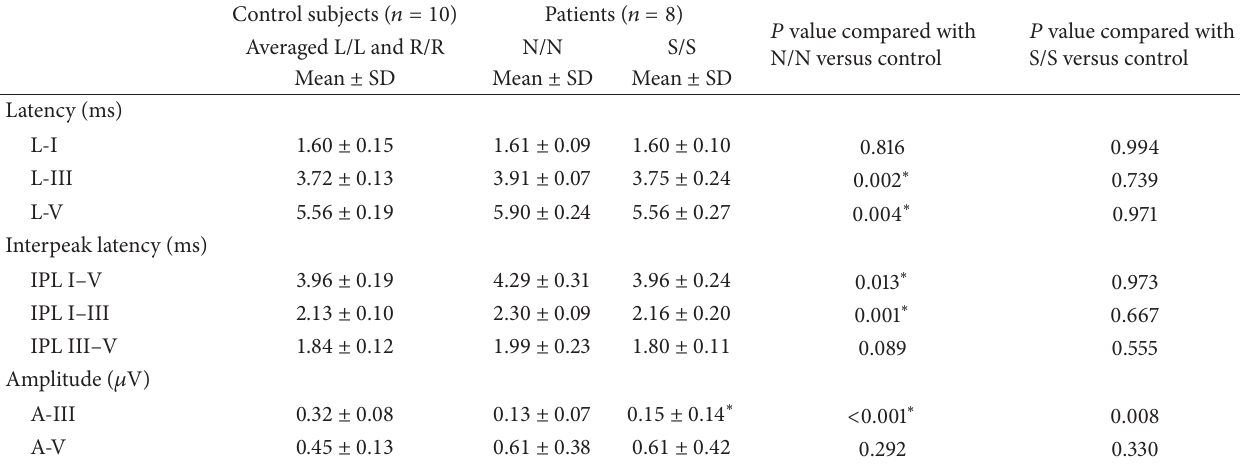
Table 4: Ipsilateral side comparisons between patients and control subjects.